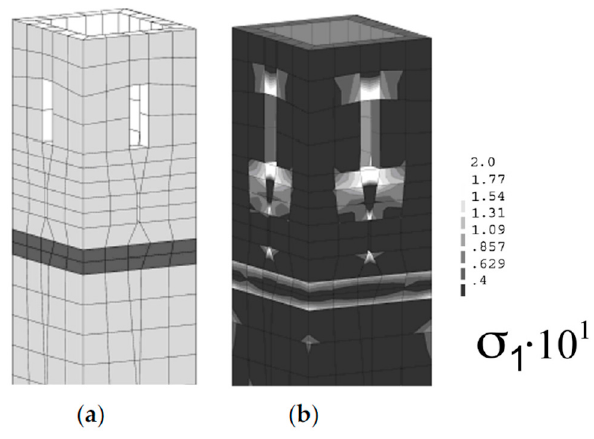
Figure 4. Torre Bonino: ( a ) detail of the stone layer discretization; ( b ) principal tensile stresses σ 1 (MPa).